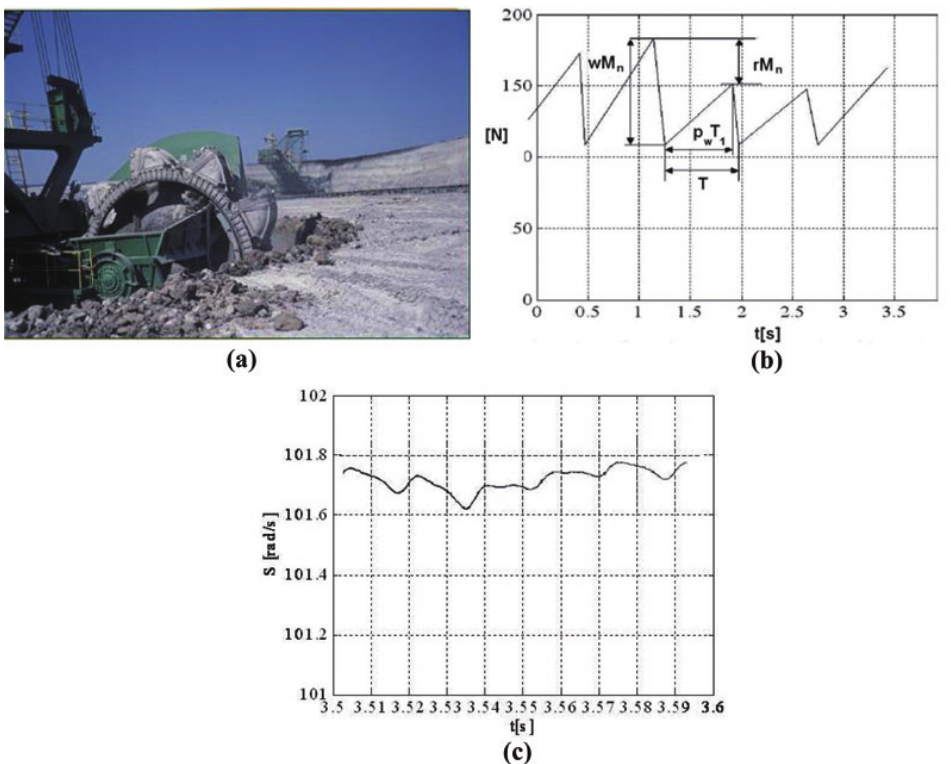
Fig. 16. (a) View of bucket wheel during operation (b) model of external load variation (c) rotational speed variation caused by varying cyclic